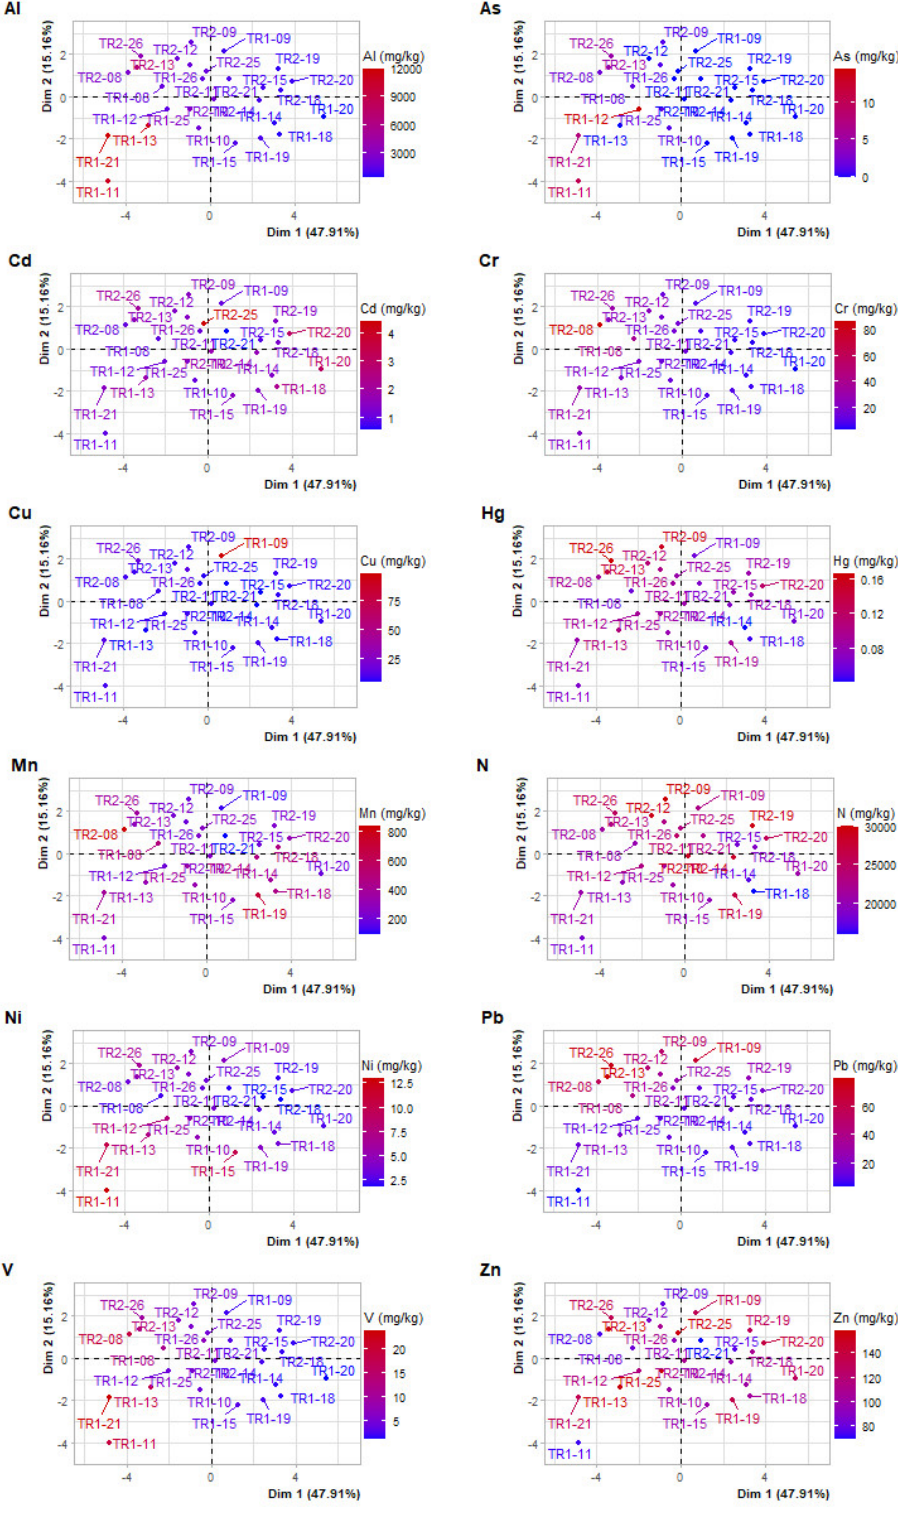
Figure 9. Untransformed concentrations of selected elements plotted over the PCA results.